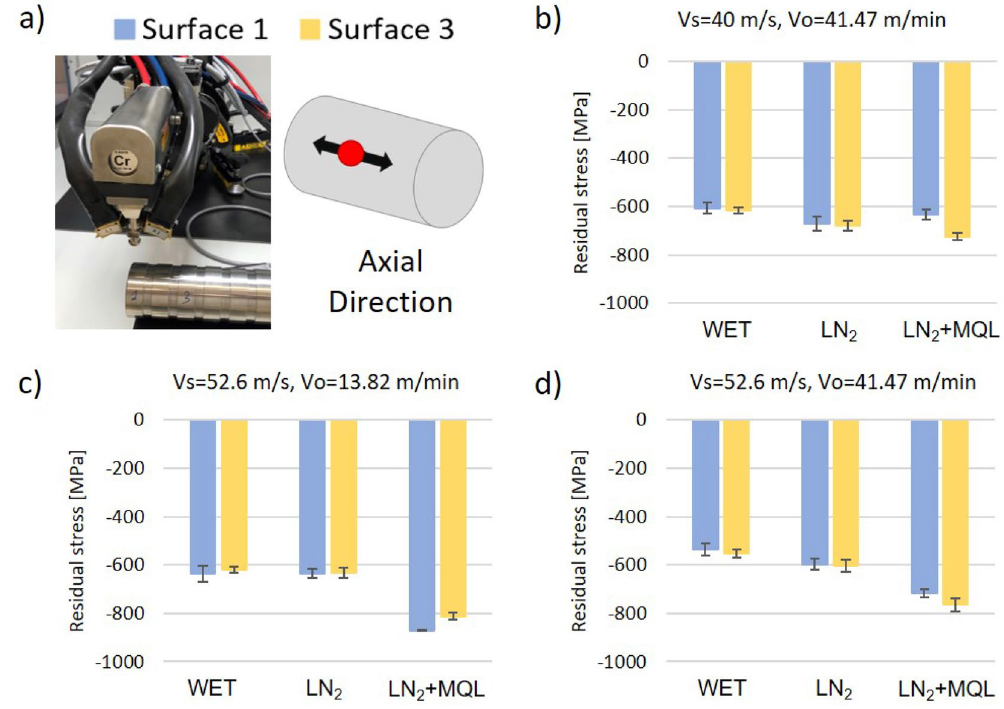
Figure 7. Axial residual stress on the first and third ground surfaces with best grinding conditions. ( a ) Scheme of measures, ( b ) Vs = 40 m/s, Vo = 41.47 m/min, ( c ) Vs = 52.6 m/s, Vo = 13.82 m/min, and ( d ) Vs = 52.6 m/s, Vo = 41.47